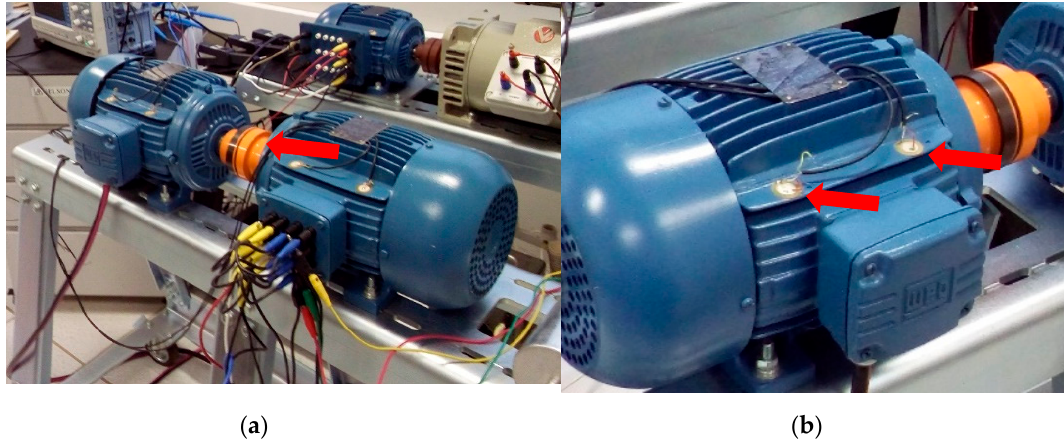
Figure 2. Joint between the two electric machines ( a ) and the sensor location on the three-phase induction motor (TIM) ( b